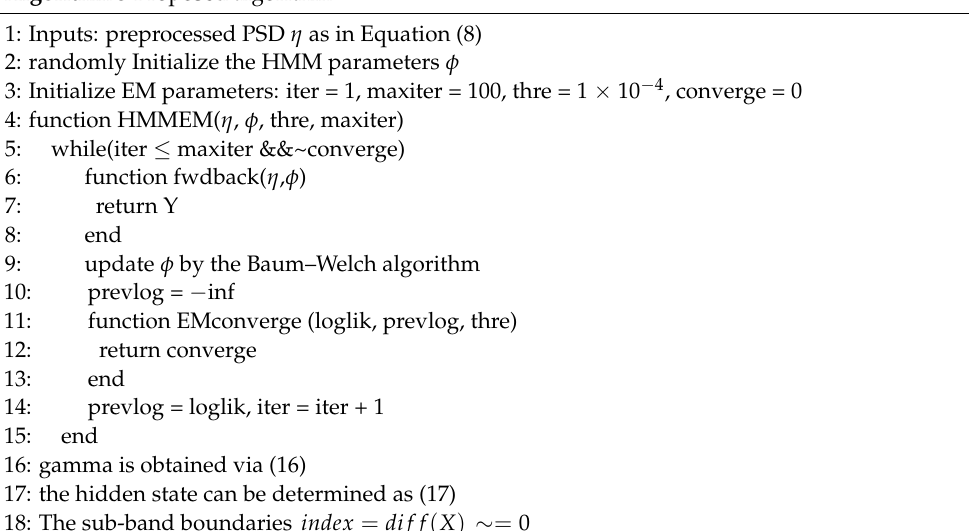
Algorithm 3 Proposed algorithm